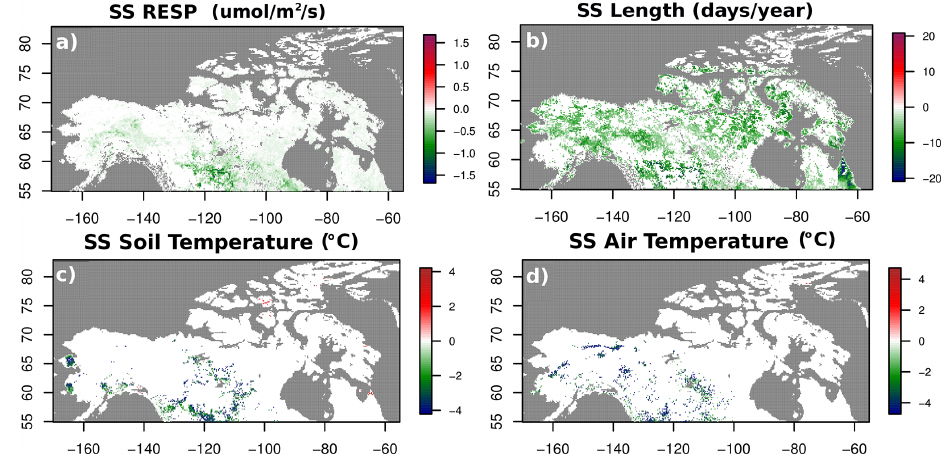
Figure 9. Sen’s slope of median change (2001–2012) in PolarVPRM estimates of snow season (SS, when SCA ≥ 50%) carbon cycle variables, and driver data. Values are only shown for locations with a statistically significant change over time ( p value < 0 .